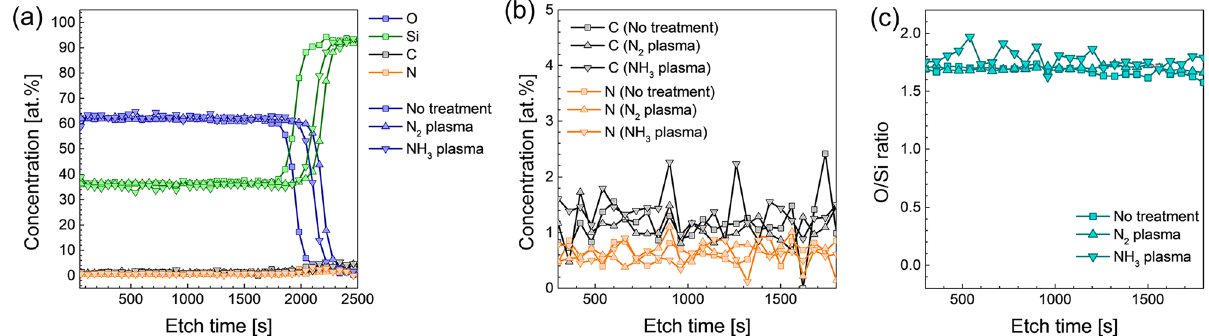
Figure 2. ( a ) Depth profiles of O, Si, C, and N; ( b ) depth profiles of C and N; ( c ) oxygen stoichiometry (O/Si ratio) of the thin films.